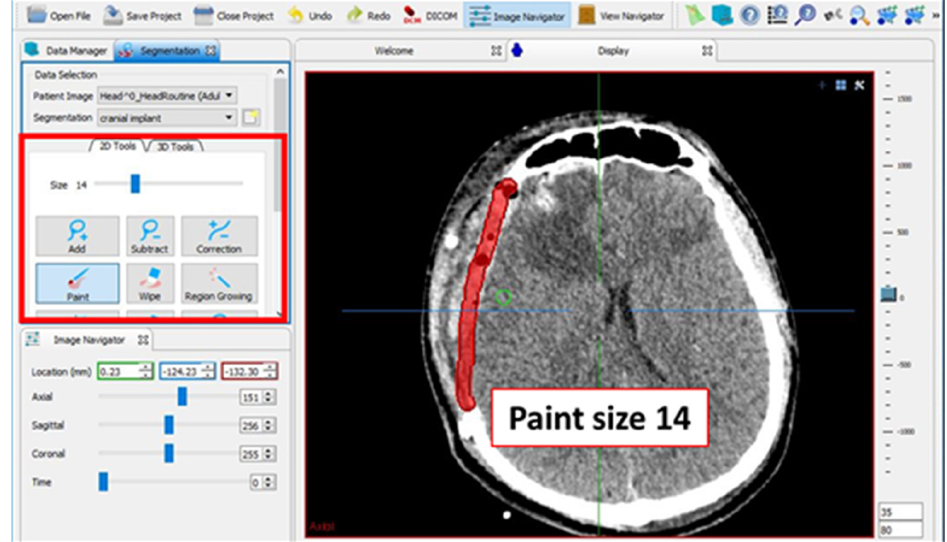
Figure 2. The “Paint” tool was used to draw the line along defective skull.